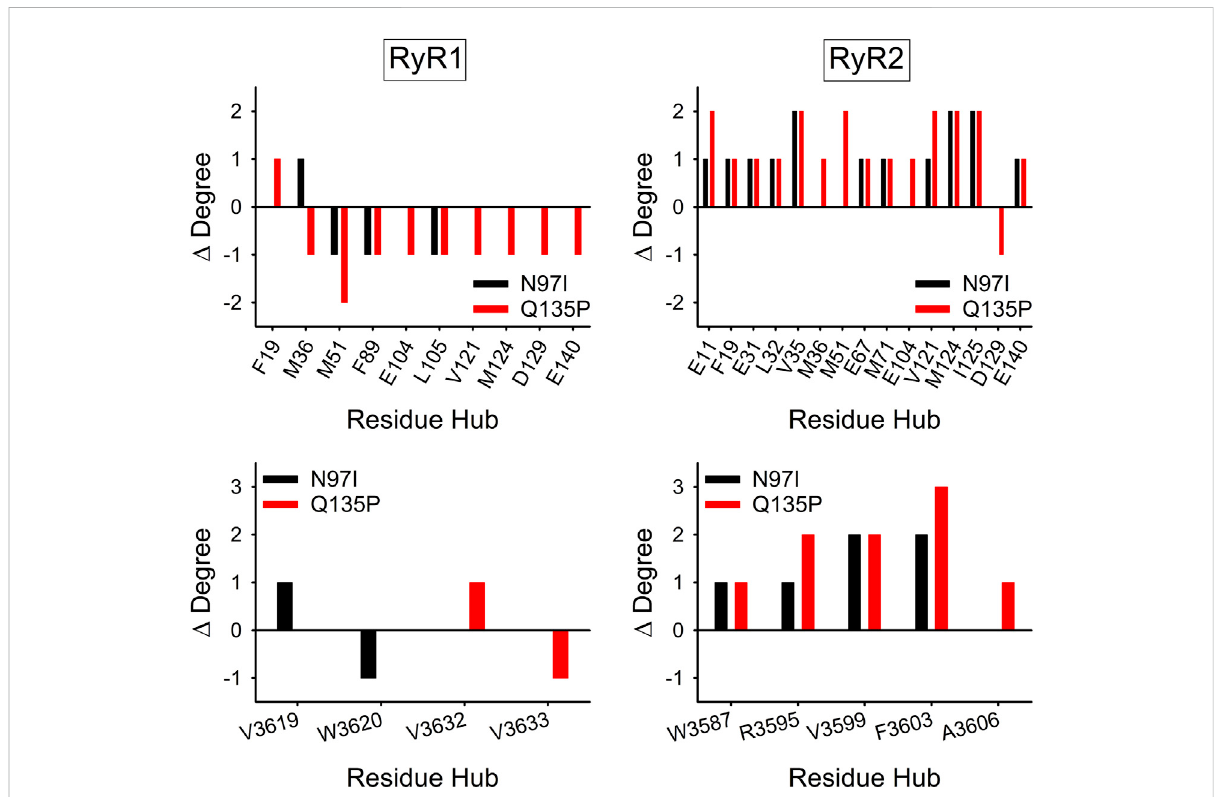
FIGURE 8 Effects of CaM variants on the connectivity of hub residues of CaM (top panels) and RyR1/2 peptides (bottom panels) . Hubs were de fi ned as residueswithdegree ≥ 6intheProteinStructureNetwork(PSN)ofatleastonevariant. Δ Degreeiscalculatedasthedifferenceinhubdegreebetween the variant (N97I: black, Q135P: red) and the